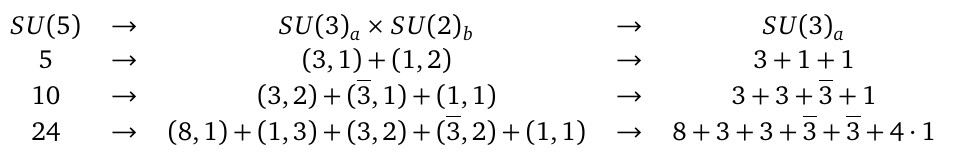
Table 9: Embedding of representations SU ( 3 ) tations of SU ( 5 )